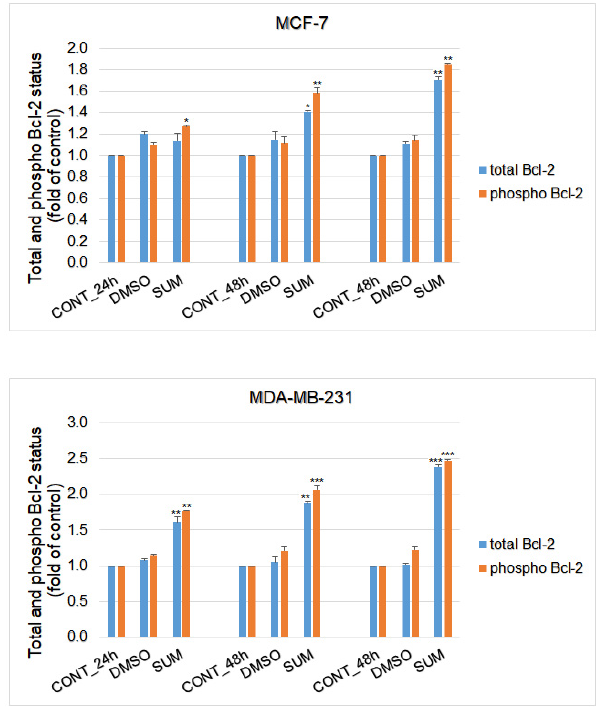
Figure 17. Flow cytometric analyses of anti-apoptotic mitochondria-associated protein Bcl-2 (total and phospho) expression after SUM treatment in MCF-7 (155 µg/mL) and MDA-MB-231 (215 µg/mL) cells. Results are expressed as mean values of three independent experiments. Significant changes, control vs. SUM-treated cells * p < 0.05, ** p < 0.01, *** p < 0.001.